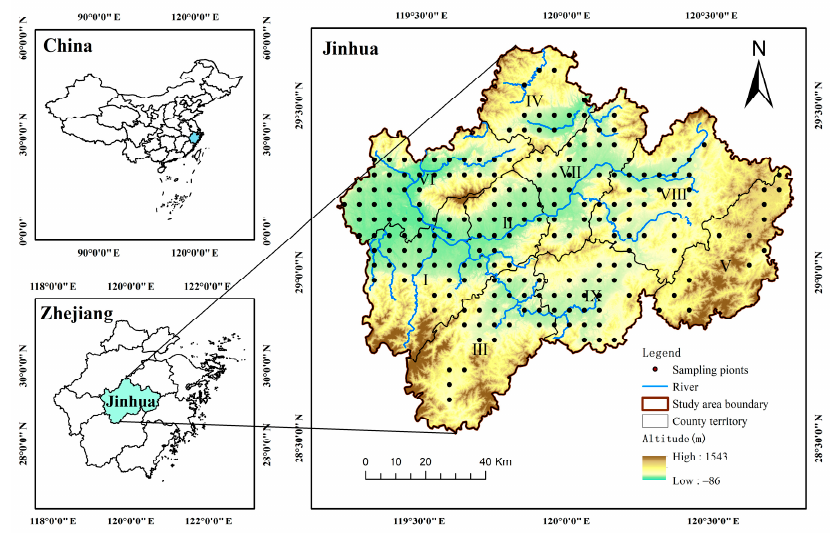
Figure 1. Schematic diagram of the study area and soil sampling sites. I: Wucheng District; II: Jindong District; III: Wuyi County; IV: Pujiang County; V: Pan’an County; VI: Lanxi City; VII: Yiwu City; VIII: Dongyang City; IX: Yongkang City.